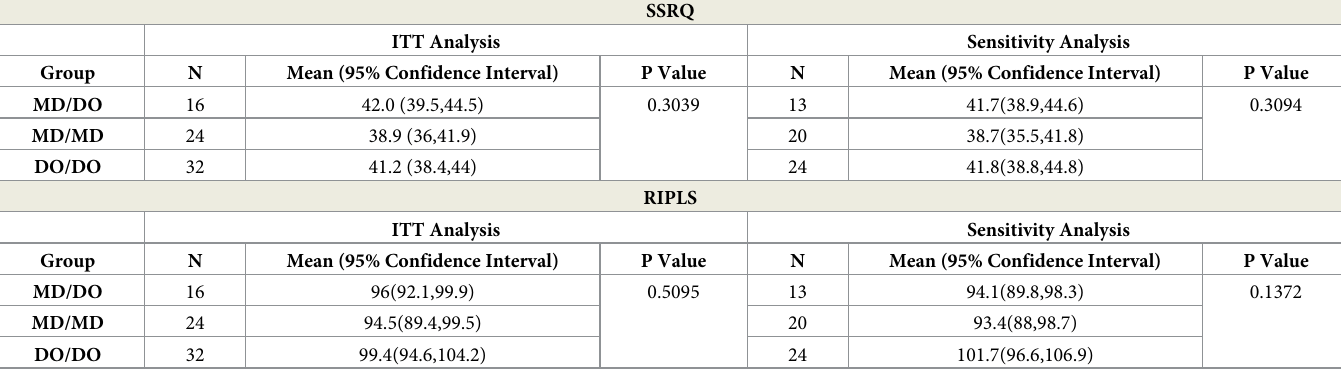
Table 1. ITT and sensitivity analysis of SSRQ and RIPLS scores between the MD/MD, MD/DO, and DO/DO groups.